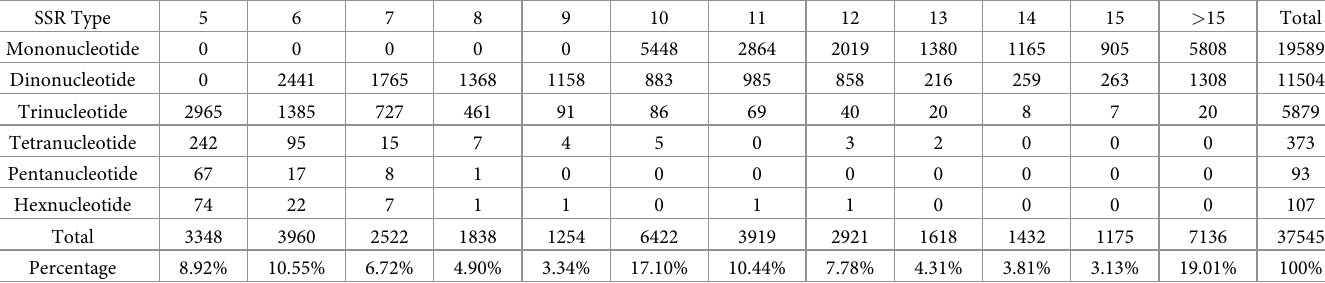
Table 3. Summary of different repeat times for SSRs isolated from the transcriptome of Rosa roxburghii